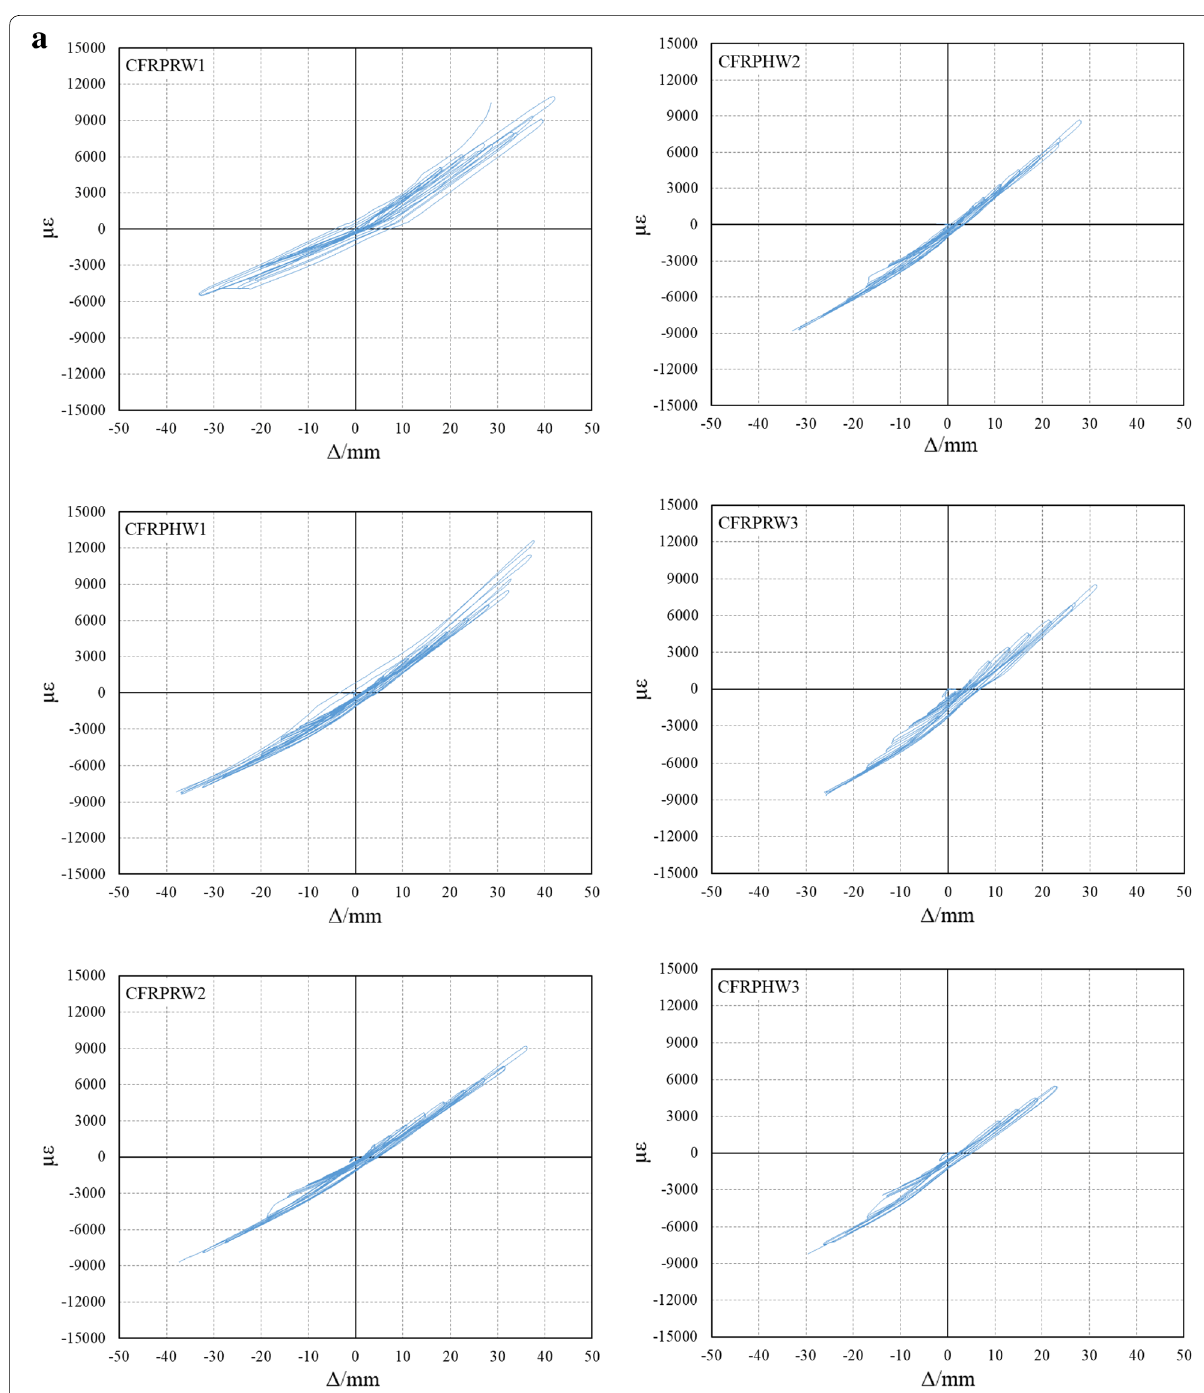
Fig. 12 Strain of CFRP bar and steel bar ( a Strain of CFRP bar. b Strain of stirrup c Strain of CFRP bar and steel bar at the same position of